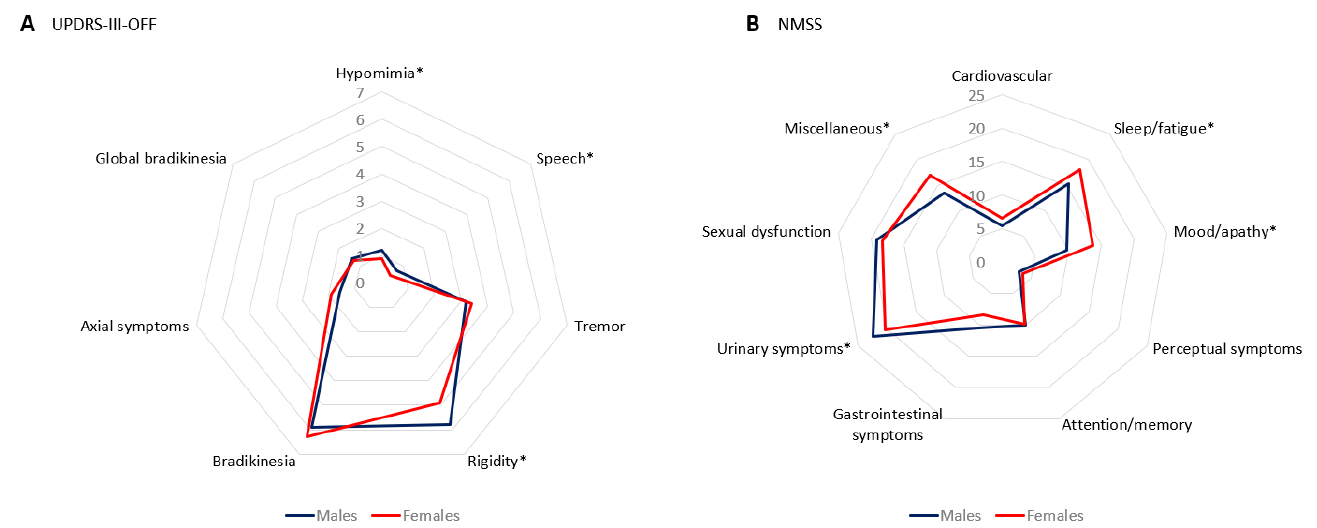
Figure 1. ( A ) Mean score of sub-scores of the UPDRS-III-OFF at baseline in PD males vs. females; *, p < 0.0001. ( B ) Mean score on each domain of the NMSS at baseline in PD males vs. females; *, p < 0.05; Sleep/fatigue, p = 0.041; Mood/apathy, p = 0.003; Urinary symptoms, p = 0.047; Miscellaneous, p = 0.010.